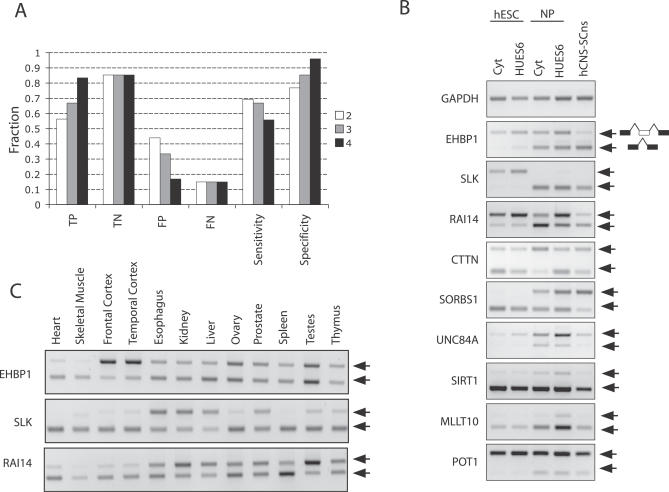
RT-PCR Validation of REAP-Predicted Alternative Exons(A) Probesets (exons) were considered REAP[+] candidates if they contained at least N = 2 (white bars), 3 (gray bars), or 4 (black bars) significant outliers. True positive (TP), true negative (TN), false positive (FP), and false negative (FN) rates were calculated from RT-PCR-validated REAP[+] exons at the different cutoffs (N = 2, 3, 4).(B) Nine RT-PCR validated REAP[+] AS events in hESCs (Cyt-ES and HUES6-ES), derived NPs (Cyt-NP and HUES6-NP), and hCNS-SCns. Arrows indicate the larger (exon-included) isoforms and smaller (exon-skipped) isoforms.(C) RT-PCR of REAP[+] alternative exons from EHBP1, SLK, and RAI14 across a panel of human tissues. Arrows indicate the larger (exon-included) isoforms and smaller (exon-skipped) isoforms.